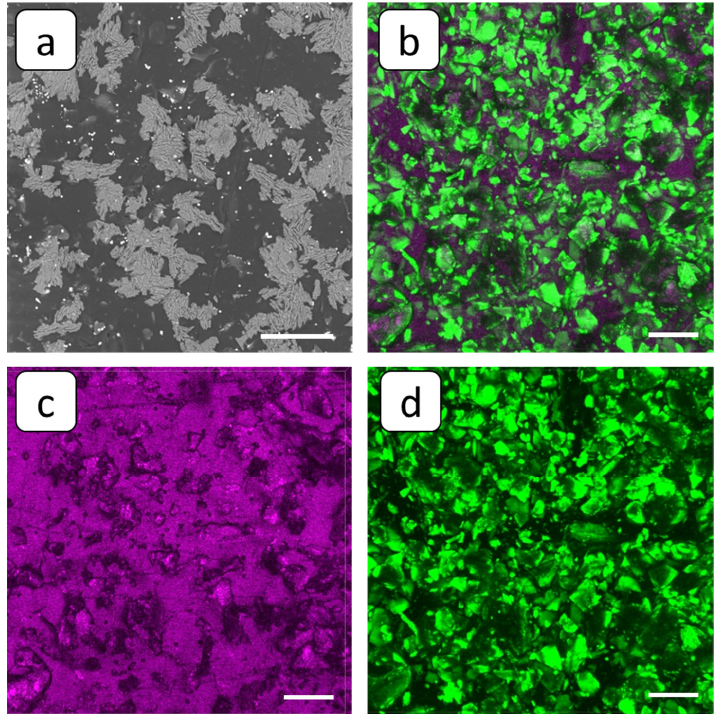
Figure 8. SEM ( a ) and FM 3D images ( b – d ) of the cation-exchange membrane MK-40 after the experiment with PAA-F2, superposition of fluorescent and reflected light ( b ), and the same view in reflected ( c ) and fluorescent ( d ) light. Scale bar: 100 µm.